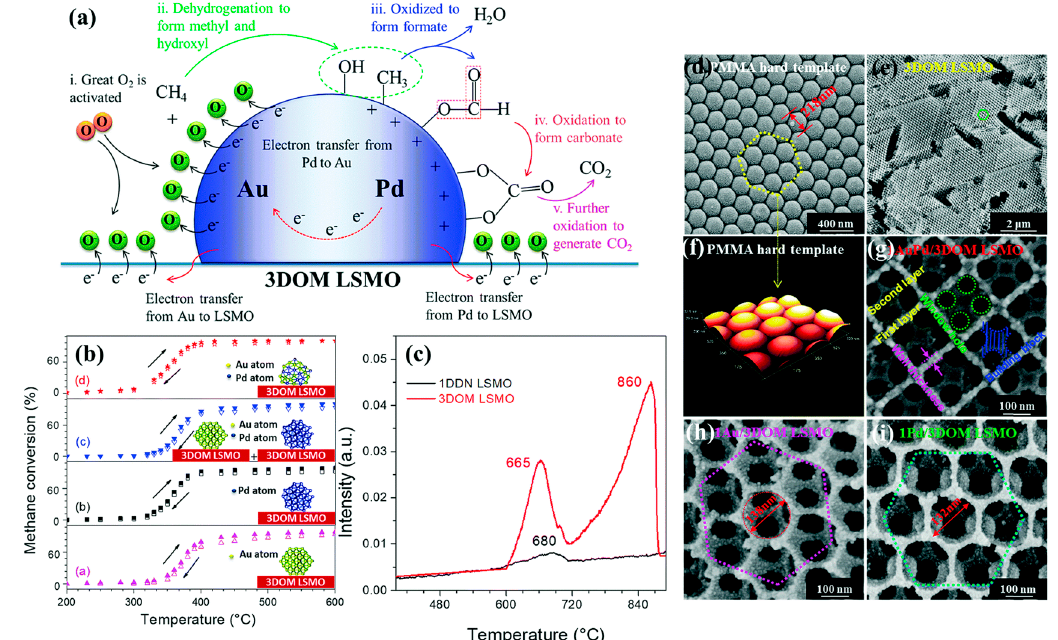
Figure 10. ( a ) Proposed elementary steps for the oxidation of methane over 1AuPd/3DOM LSMO; ( b ) methane conversion; ( c ) NH 3 -TPD profiles of 1DDN LSMO and 3DOM LSMO samples; ( d – i ) HRSEM and 3D-eAFM images of PMMA, 3DOM LSMO, and noble-metal-supported 3DOM LSMO. Reprinted with permission from Ref. [49]. Copyright 2016, copyright American Chemical Society.